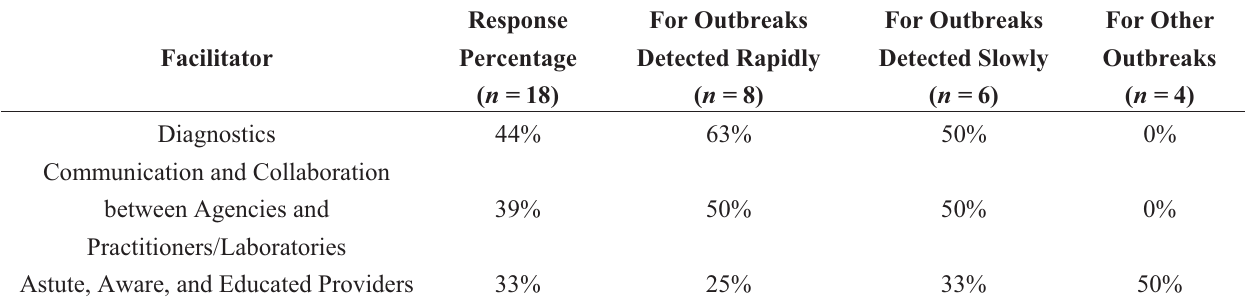
Table 4. Top Three Facilitators for Zoonotic Disease Outbreak Detection and